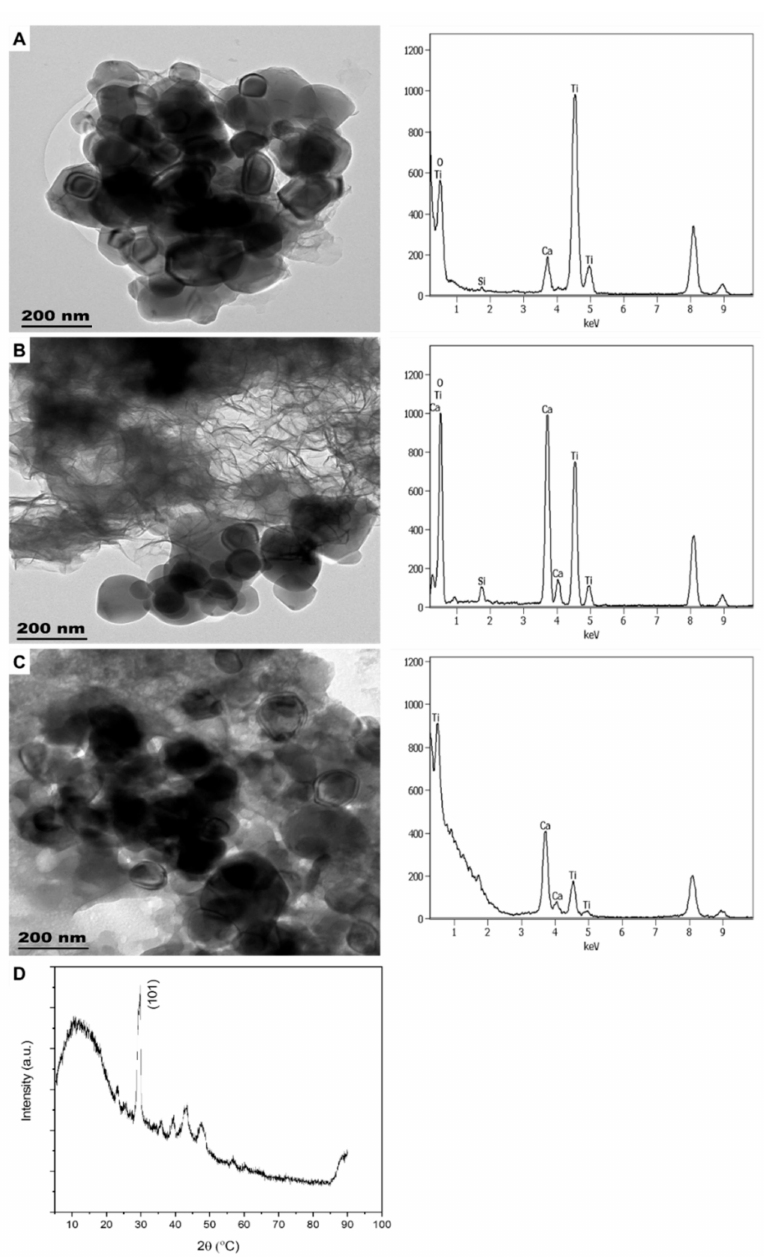
Figure 5. Transmission electron microscopy coupled with energy-dispersive X-ray (TEM-EDX) analy- sis of ENMs obtained from CM1 after ( A ) sequential ultrasonication, ( B ) Soxhlet extraction, ( C ) diluted nano-enabled products (NEPs), and ( D ) corresponding X-ray powder diffraction (XRD) spectra. The “suspect” products, CA1 and CA2, were found to contain ENMs (Figure 4); thus, they were confirmed as NEPs. CA1 had elongated nTiO 2 sized 8 ± 2 × 53 ± 18 nm and near-spherical nAg sized 27.5 ± 7 nm. CA2 had near-spherical nAg particles with a size range of 21.7 ± 6 nm. Although CA1 and CA2 were from different manufacturers, their nAg sizes were relatively similar. The zeta potentials of the ENMs in CA1 and CA2 were closely related at − 34 and − 36 mV, respectively. Similar to LB1, XRD analysis for CA1–2 could not be undertaken because of the low sample mass obtained after the extraction